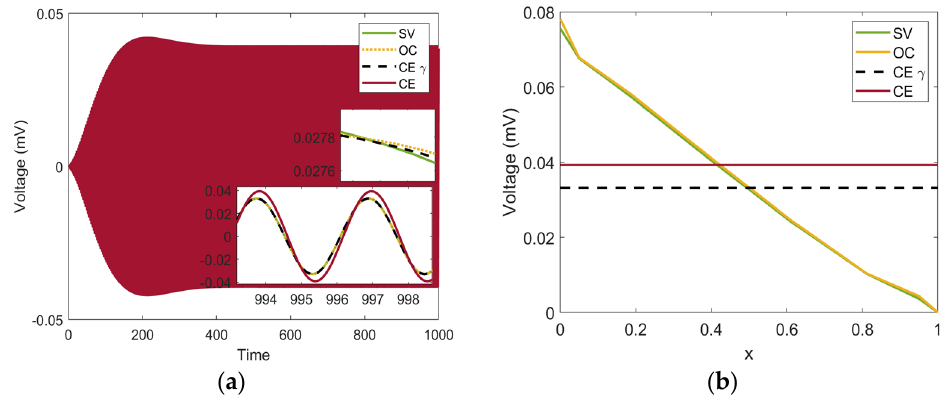
Figure 4. ( a ) Voltage time history and ( b ) voltage with respect to x .